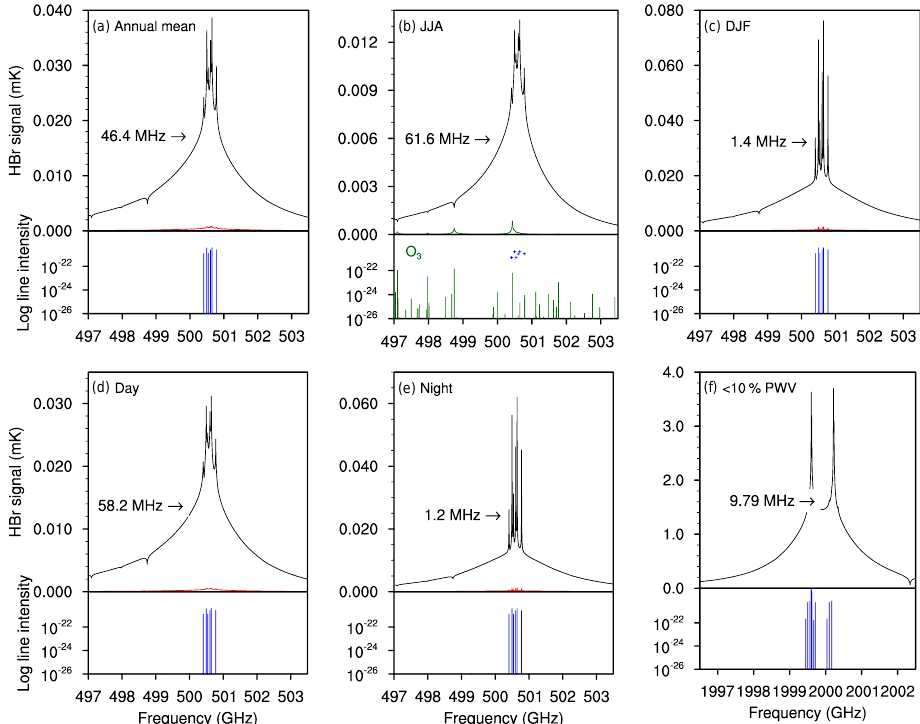
Figure 10. The spectrally enhanced HBr signal (1MHz sampling resolution) around the strongest signal in each scenario (a–f) at Summit, calculated as a residual between simulations with and without HBr. Red lines show the differences that result from using the Ma and Tipping water vapour continuum model. Arrows point to the position of the FWHM of the peak signal in each plot, labelled with the corresponding bandwidth. Units of the ordinate scale are mK. The lower panels in each scenario show HBr intensities taken from the HITRAN database with log 10 units of cm 2 (moleculescm − 2 ). The green line in the top panel of (b) shows the differences that result from doubling the vertical column of ozone concentrations at pressures < 200hPa to simulate a stratospheric increase. The lower panel of (b) presents the ozone line intensities with HBr lines reduced to scatter points for